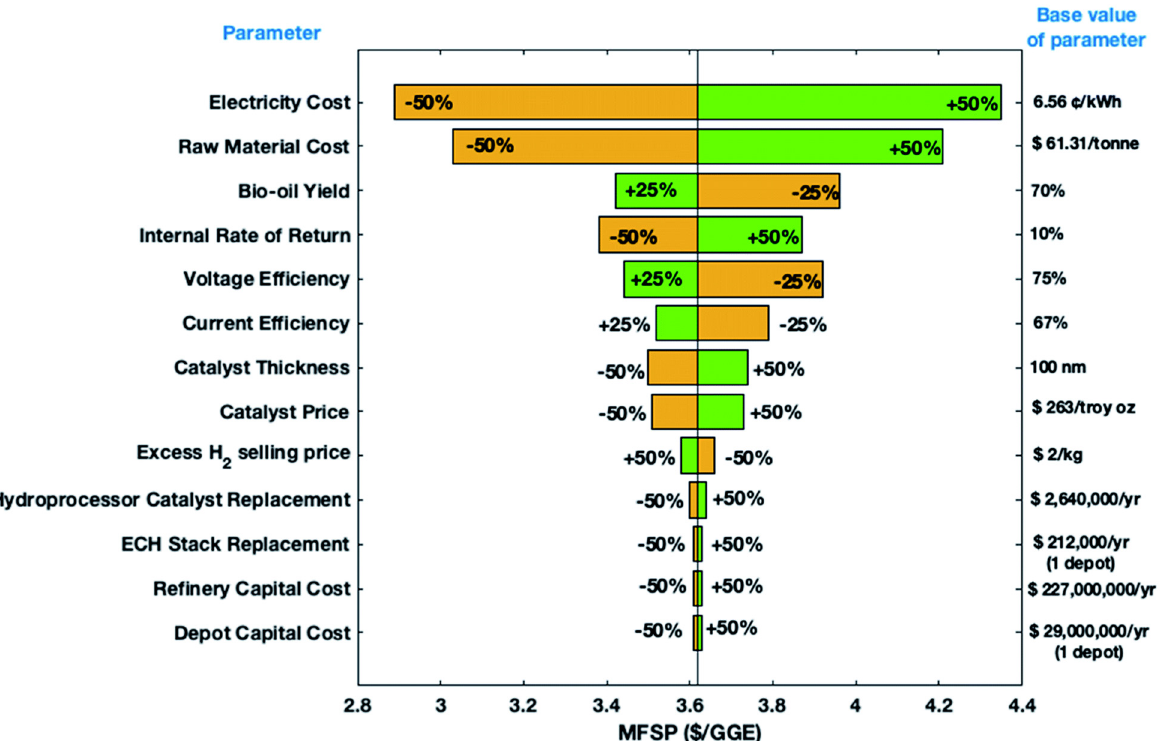
Figure 17. Tornado plot showing MFSP single parameter sensitivity analyses for the pyrolysis-ECH- Hydro-processing system (Depot size of 500 tons per day and refinery size of 2000 tons per day). Reproduced with permission from ref [39]. Copyright 2022 The Royal Society of Chemistry.